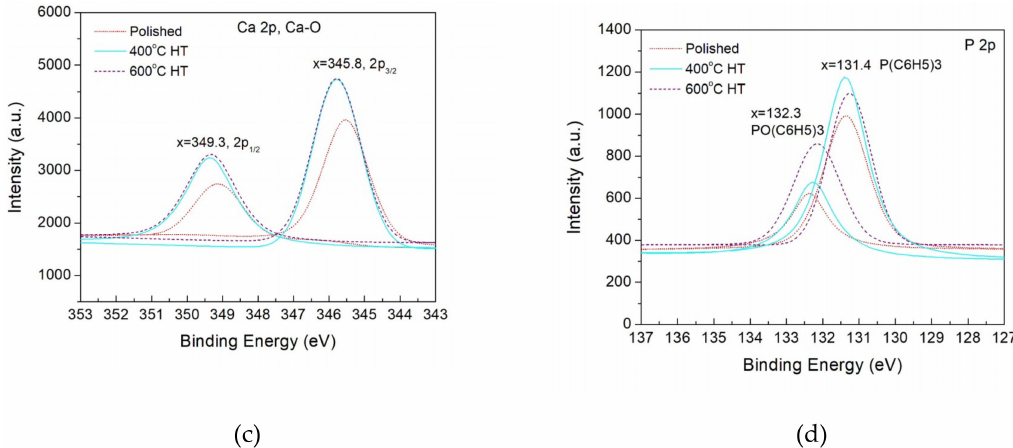
Figure 9. High resolution XPS analysis of the deposition on the surfaces after UV light irradiated immersion. ( a ) C1 s , ( b ) O1 s , ( c ) Ca2 p and ( d ) P2 p